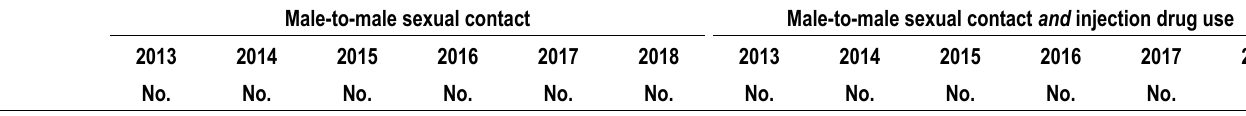
Table 10b. Stage 3 (AIDS) attributed to male-to-male sexual contact and male-to-male sexual contact and injection drug use, by selected characteristics, 2013–2018—United States and 6 dependent